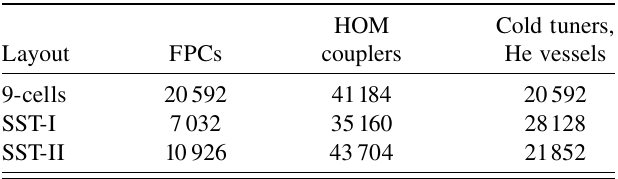
TABLE I. Number of structures and their auxiliaries for three layouts of the 500 GeV TESLA collider (without 2% energy overhead).